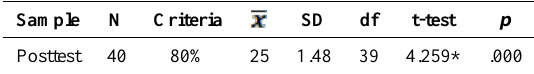
Table 5. Student ATS post-test testing